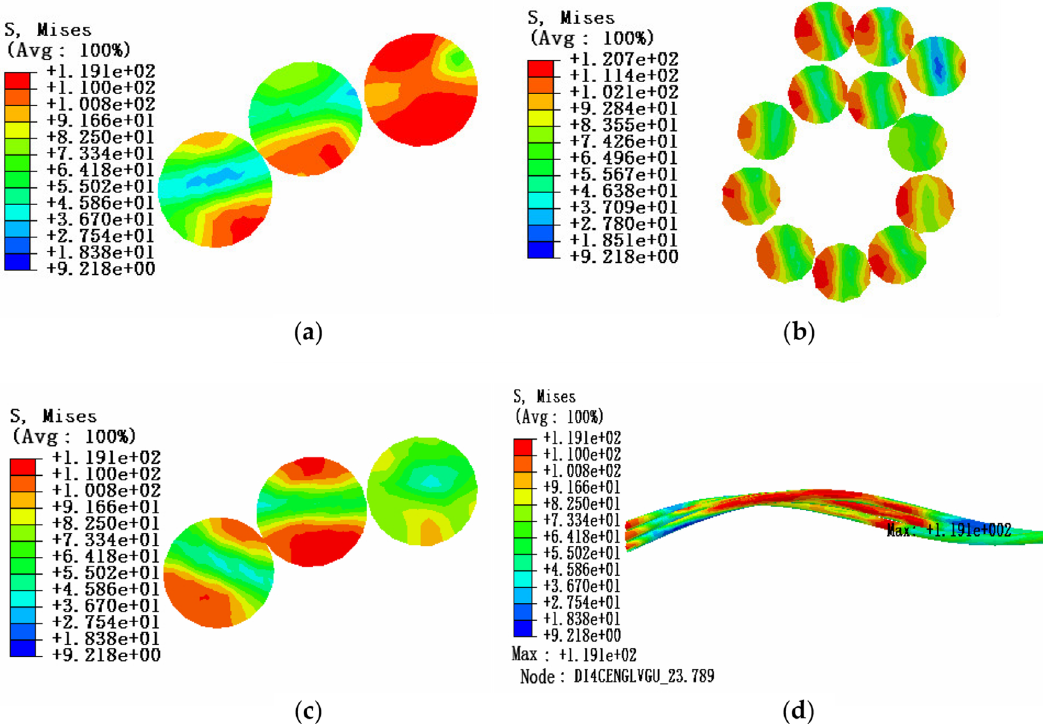
Figure 12. Equivalent stress cloud diagram of aluminum strand at 10% RTS ( a) Equivalent stress cloud diagram at maximum stress; ( b ) Equivalent stress cloud diagram at the middle point section; ( c ) Equivalent stress cloud diagram at 0.5 times the pitch diameter; ( d ) Overall equivalent stress cloud diagram of aluminum strand.